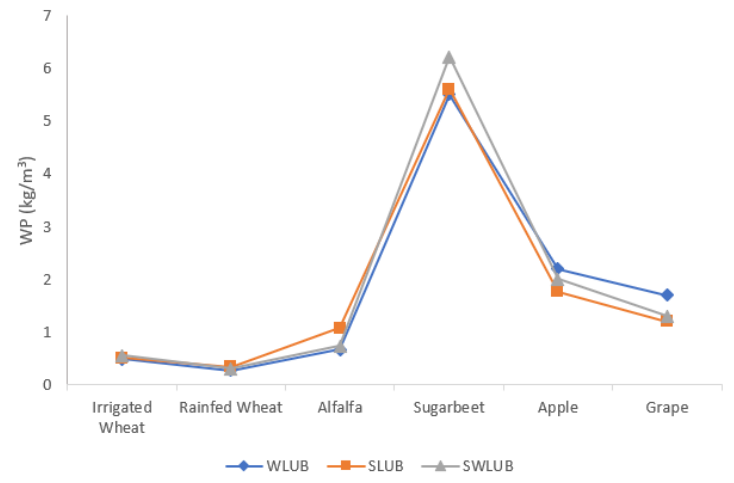
Figure 8. The WP status and comparison its comparison among three major agricultural lands in